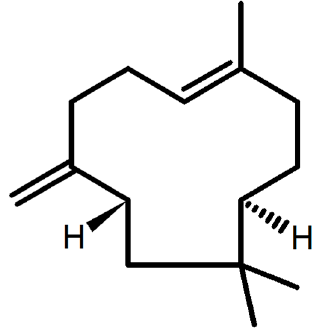
Figure 1. β -Caryophyllene (BCP) structure.